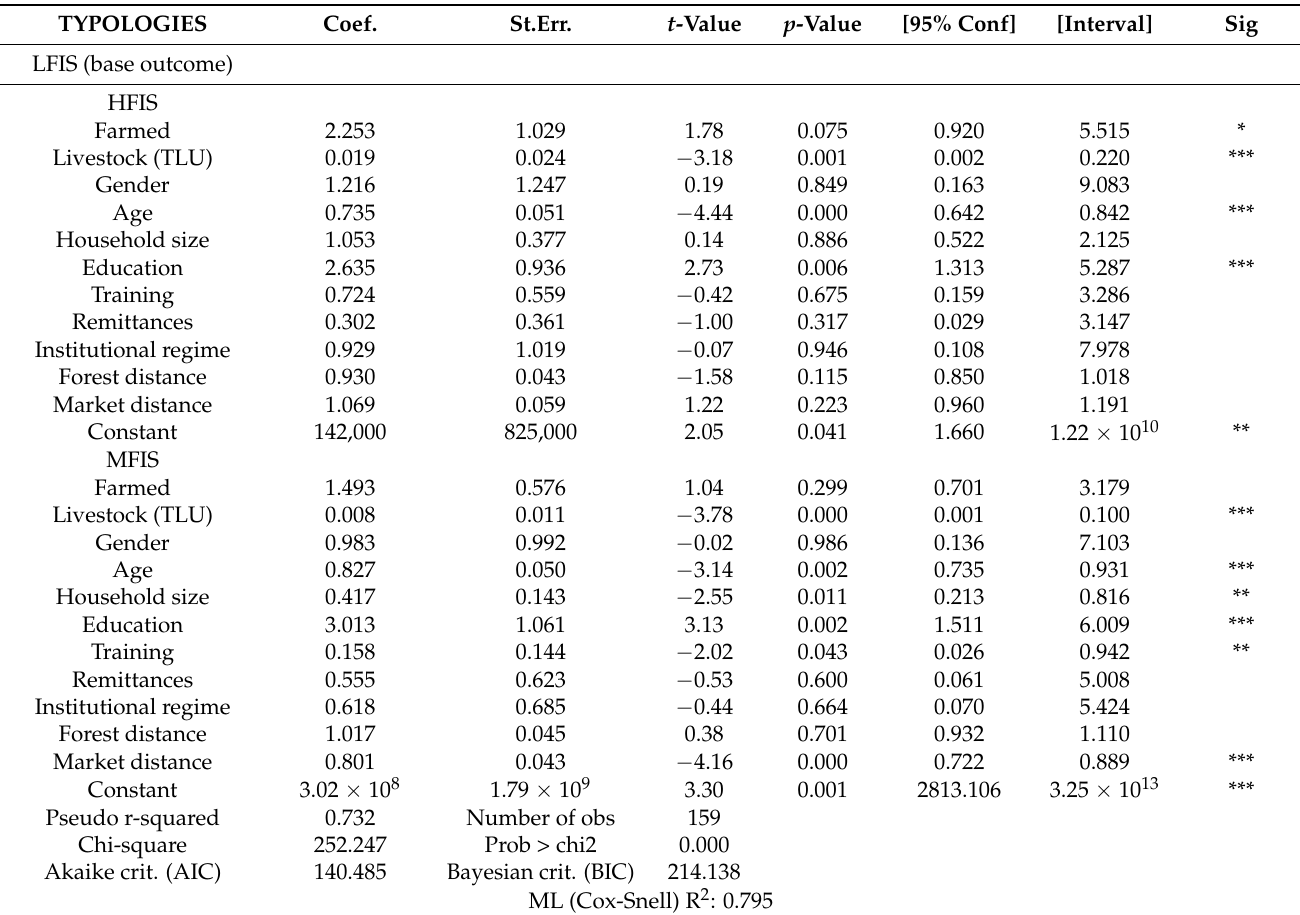
Table 5. Determinants of Forest Typologies in West Usambara. TYPOLOGIES